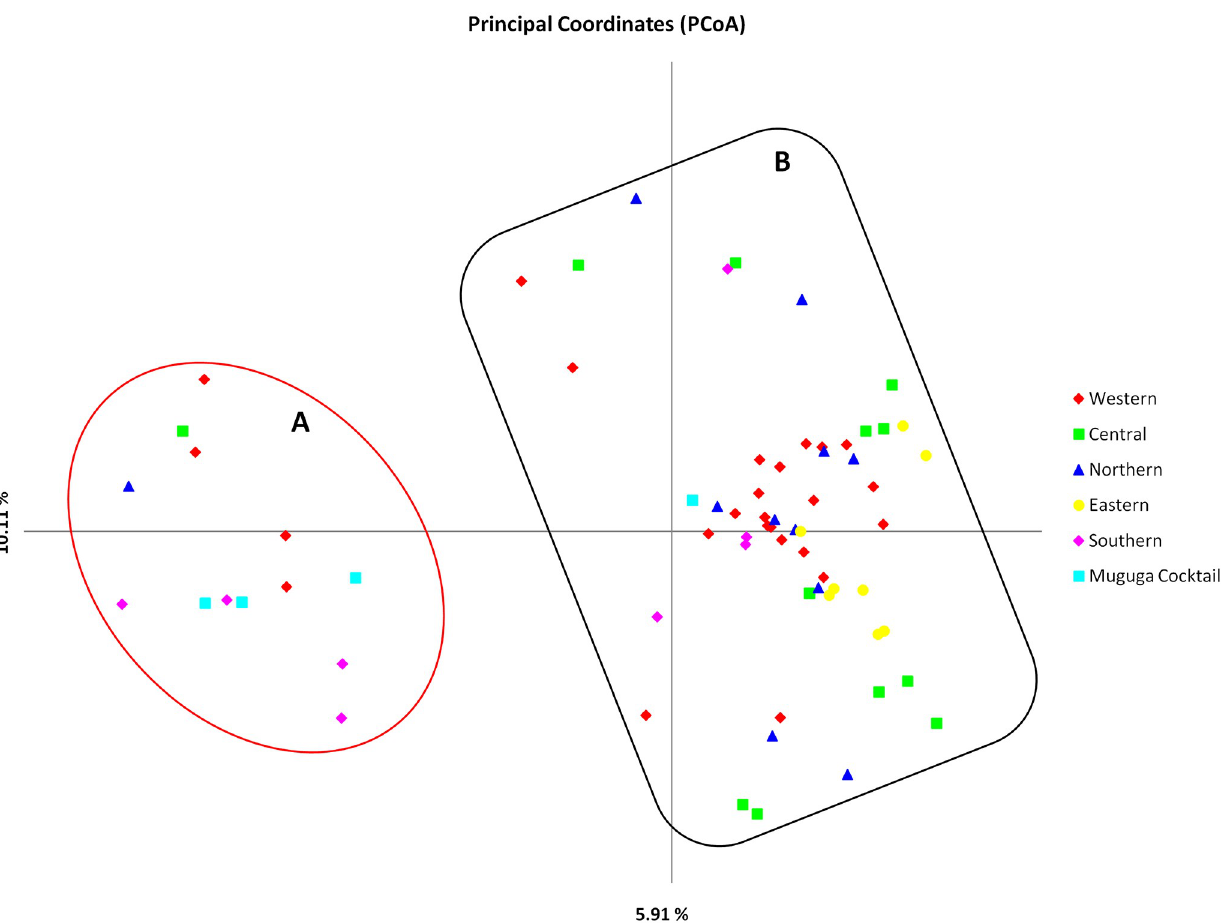
Fig 10. Principal component analysis of field samples from Burundi and Muguga cocktail vaccine. Moderate sub-structuring between populations A (comprising of samples from the Northern, Southern, Western and Central regions as well as Muguga cocktail vaccine) and B (comprising of samples from the Northern, Southern, Eastern, Western and Central regions together with the Muguga cocktail vaccine) can be observed. The numbers in the parenthesis on each axis indicate the proportion of variance in the population data set. (Table 1) and 60.1% (Table 2) of the samples were positive for T . parva (Tables 1 and 2), thus